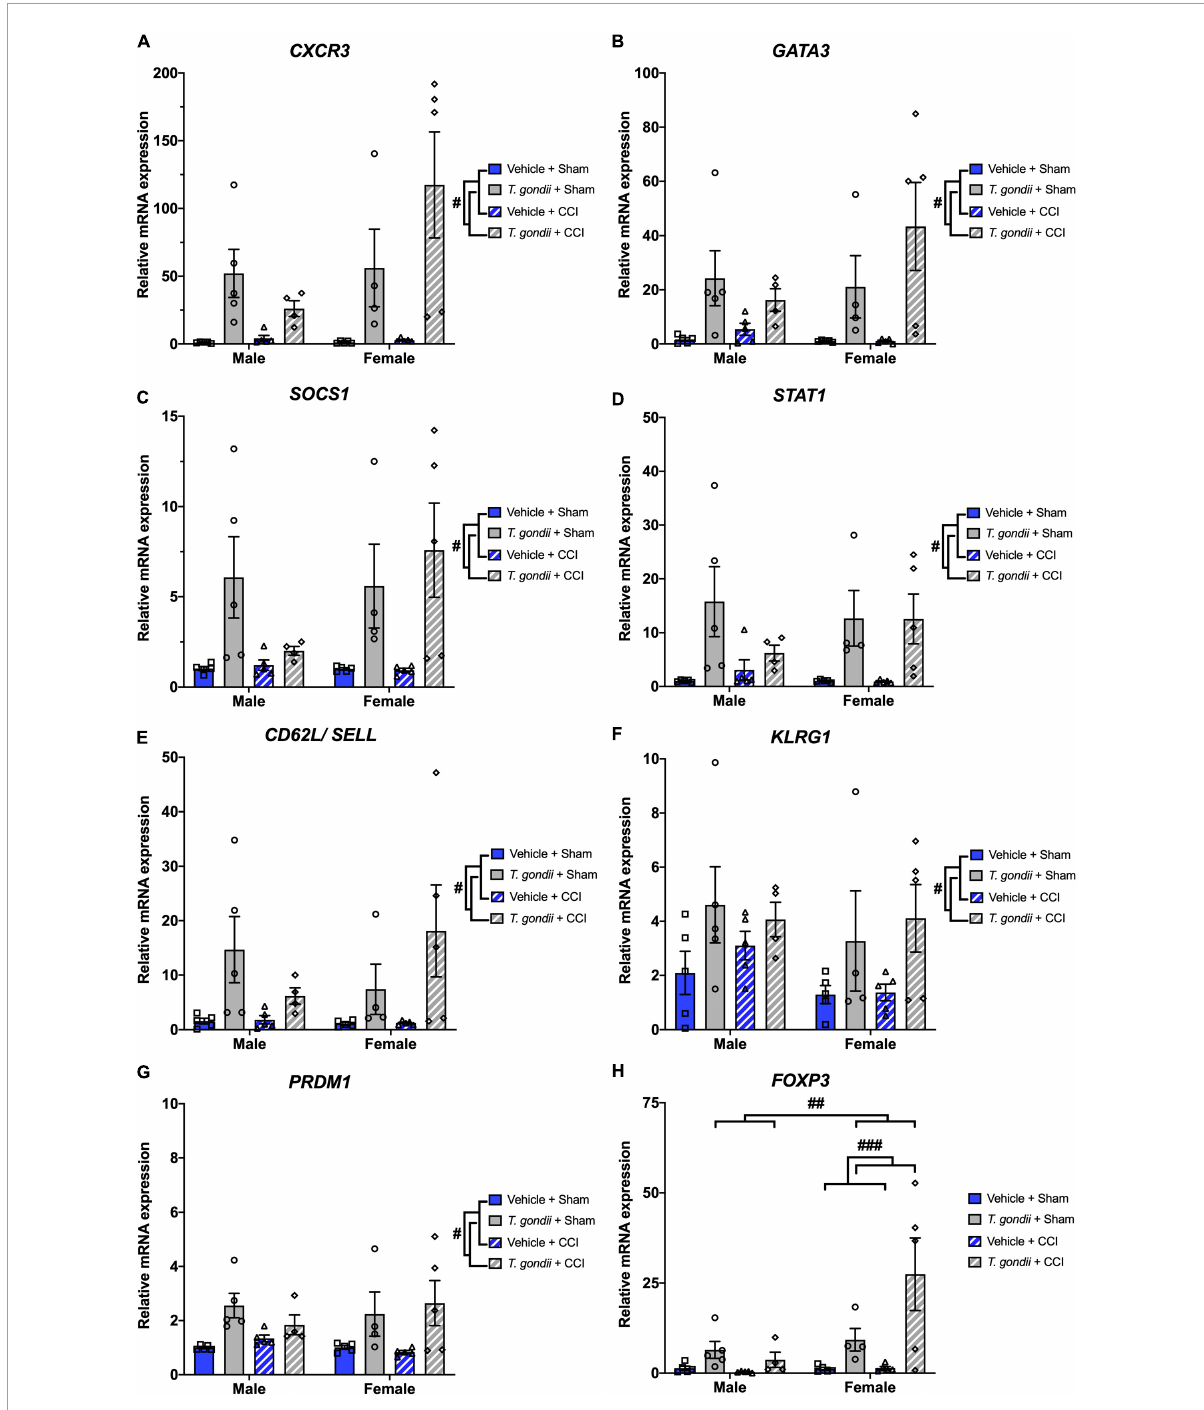
FIGURE5 Toxoplasma gondii infection increases gene expression of CD4 + and CD8 + T-cell markers within the ipsilateral cortex chronically post-controlled cortical impact (CCI). T. gondii -infected mice had increased CXCR3 (A) , GATA3 (B) , SOCS1 (C) , STAT1 (D) , CD62L/SELL (E) , KLRG1 (F) , PRDM1 (G) , and FOXP3 (H) . On top of this, T. gondii -infected females had increased expression of FOXP3 compared to both T. gondii -infected males and vehicle females. # T. gondii -infected mice significantly differ from vehicle mice, ## T. gondii -infected females significantly differ from T. gondii -infected males, ### T. gondii -infected females significantly differ from vehicle females, p < 0.05. n = 4–5/group/sex. Data shown is mean ±